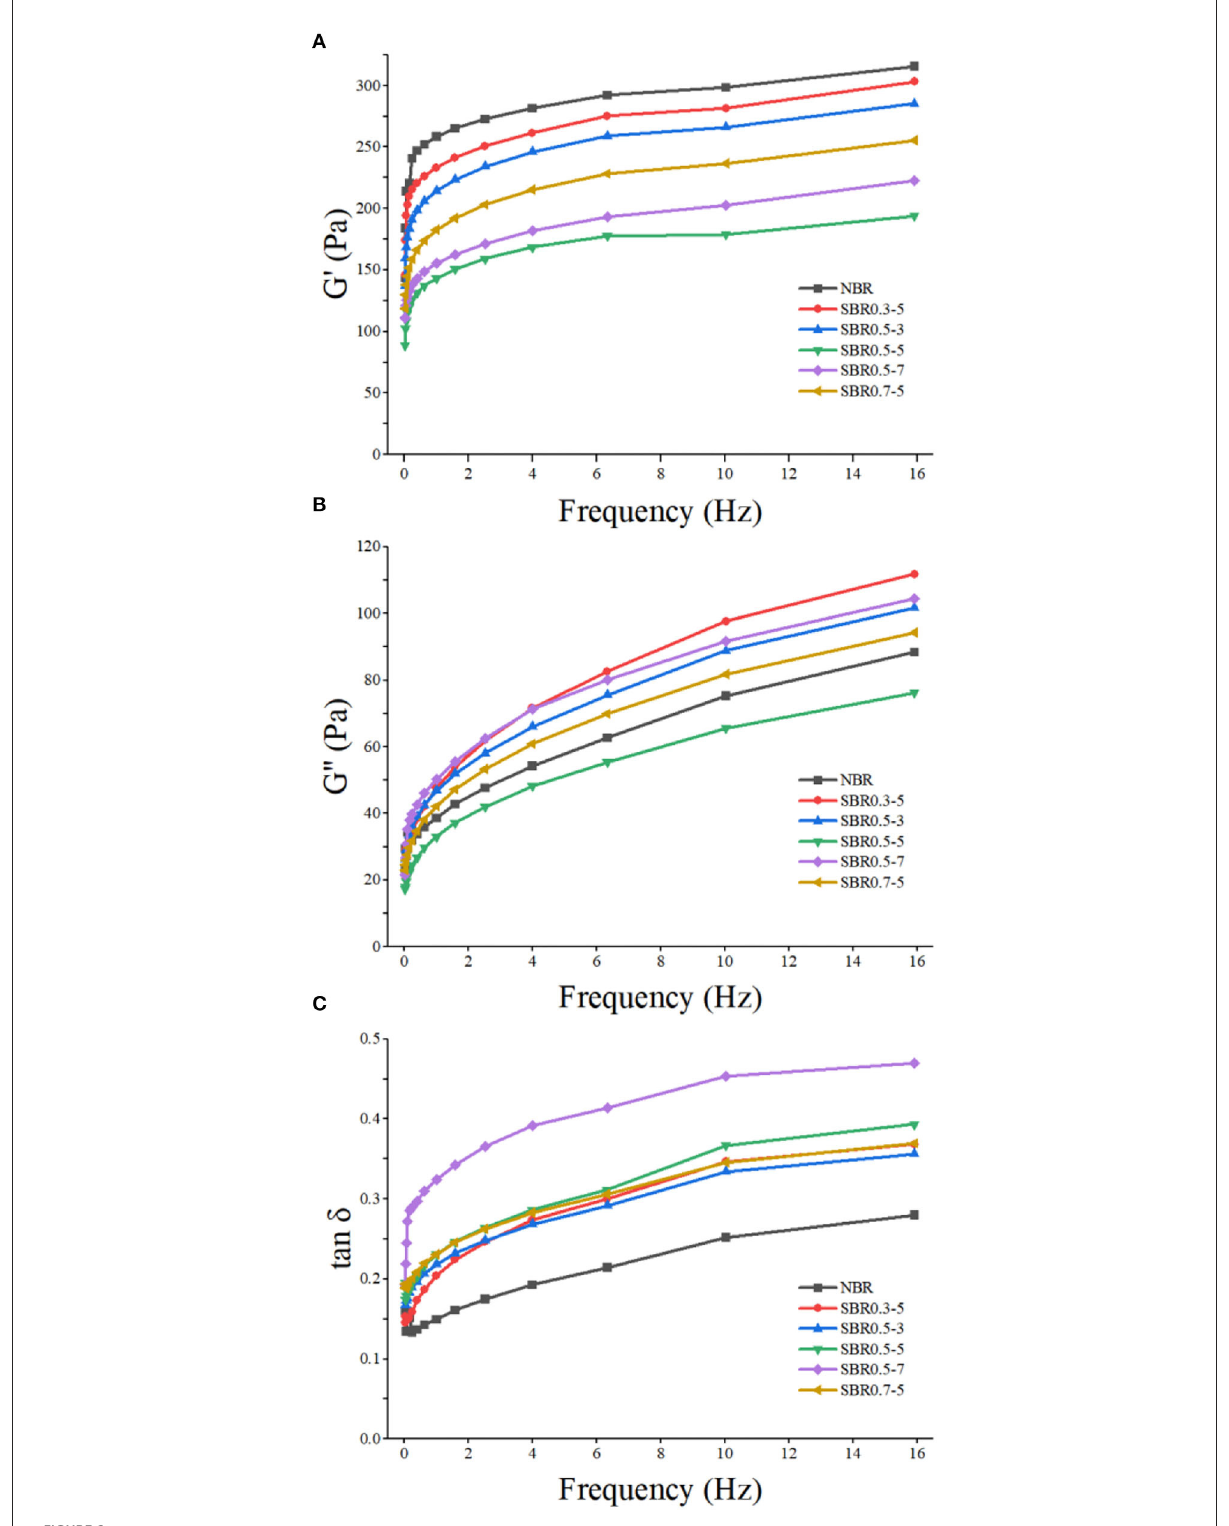
FIGURE6 Rheograms of dynamic rheological properties of brown rice paste during frequency sweep. (A) G’ of samples, (B) G” of samples, (C) tan δ of samples. NBR, native brown rice powder; SBR, steam exploded brown rice powder; SBR0.3-5, SBR at 0.3 MPa for 5min; SBR0.5-3, SBR at 0.5 MPa for 3min; SBR0.5-5, SBR at 0.5 MPa for 5min; SBR0.5-7, SBR at 0.5 MPa for 7min, SBR0.7-5, SBR at 0.7 MPa for